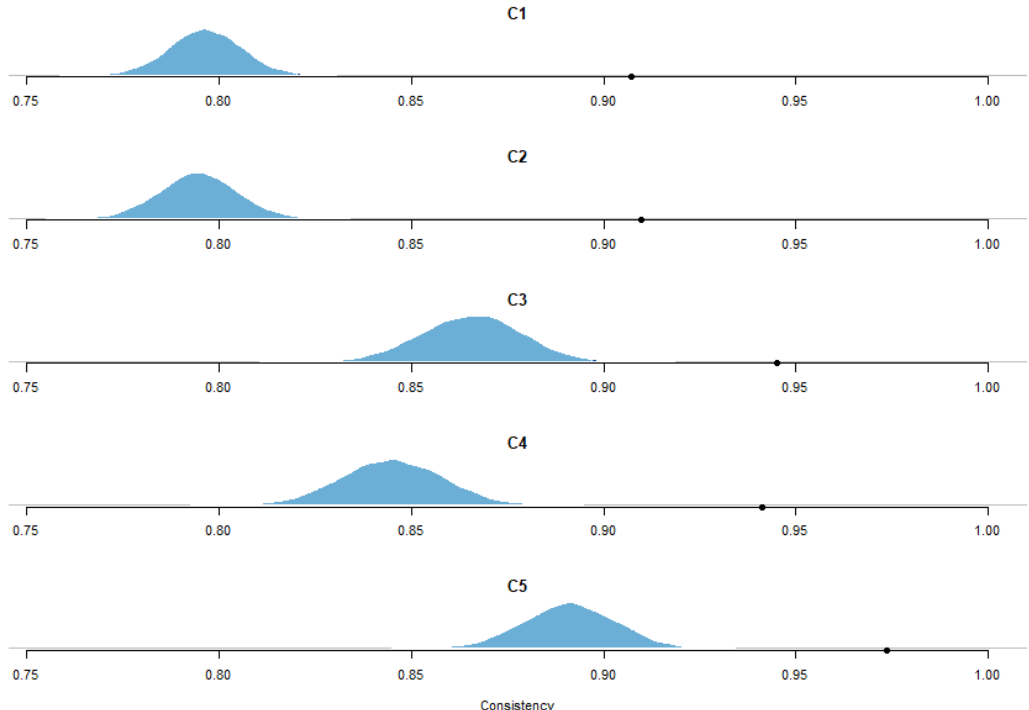
Figure 10. Observed consistencies and consistency distributions based on permutations for high